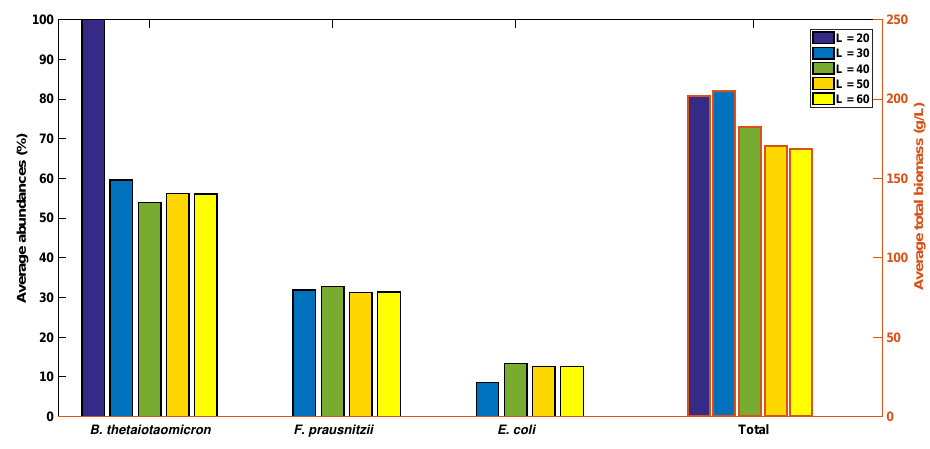
Figure 8. Effect of the biofilm thickness L on the adundance of each species and the total biomass concentration averaged across the